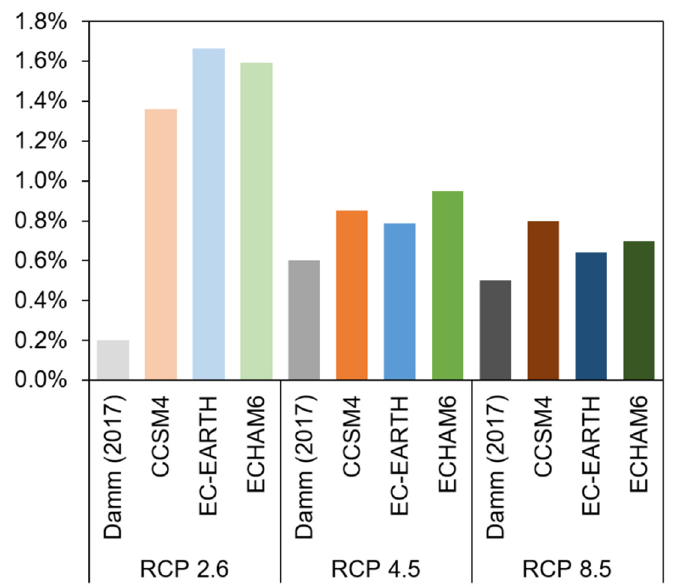
Figure 7. Annual variation of the climate driven component of energy demand for our different scenarios. Benchmarking against Damm et al. [29], giving average values from 5 RCMs for each RCPs.